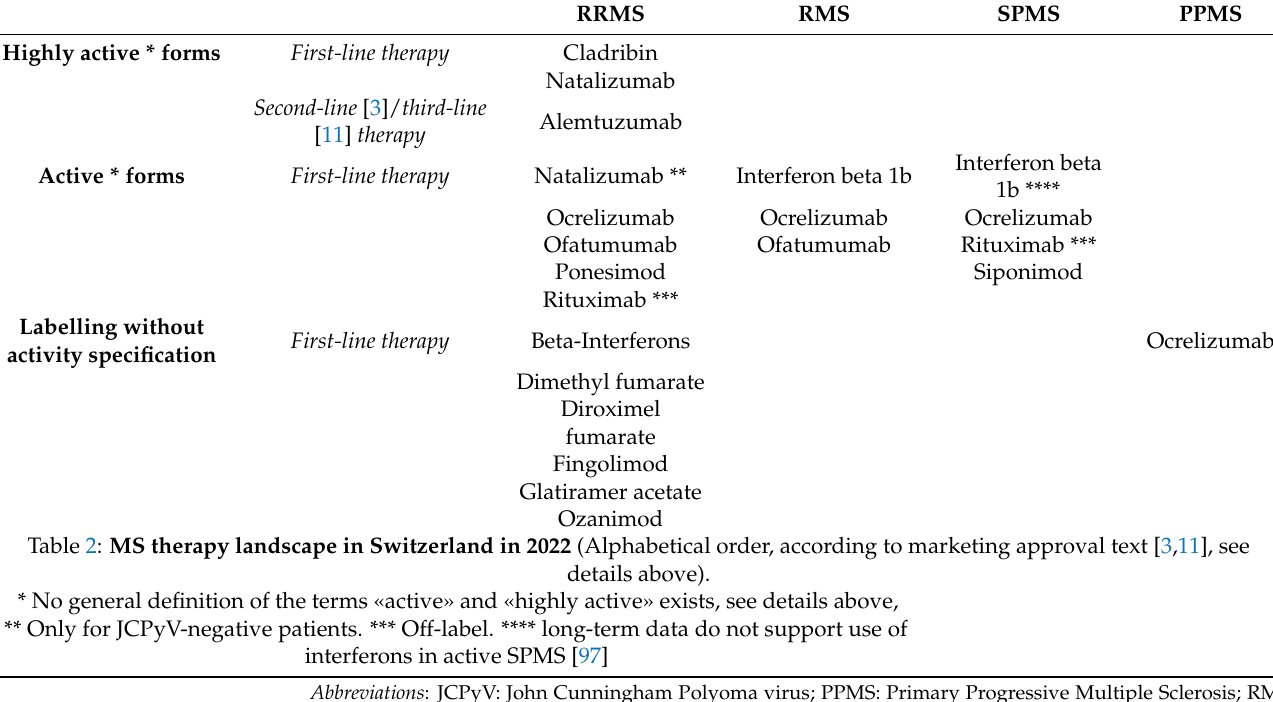
Table 15. MS therapy landscape in Switzerland in 2022.